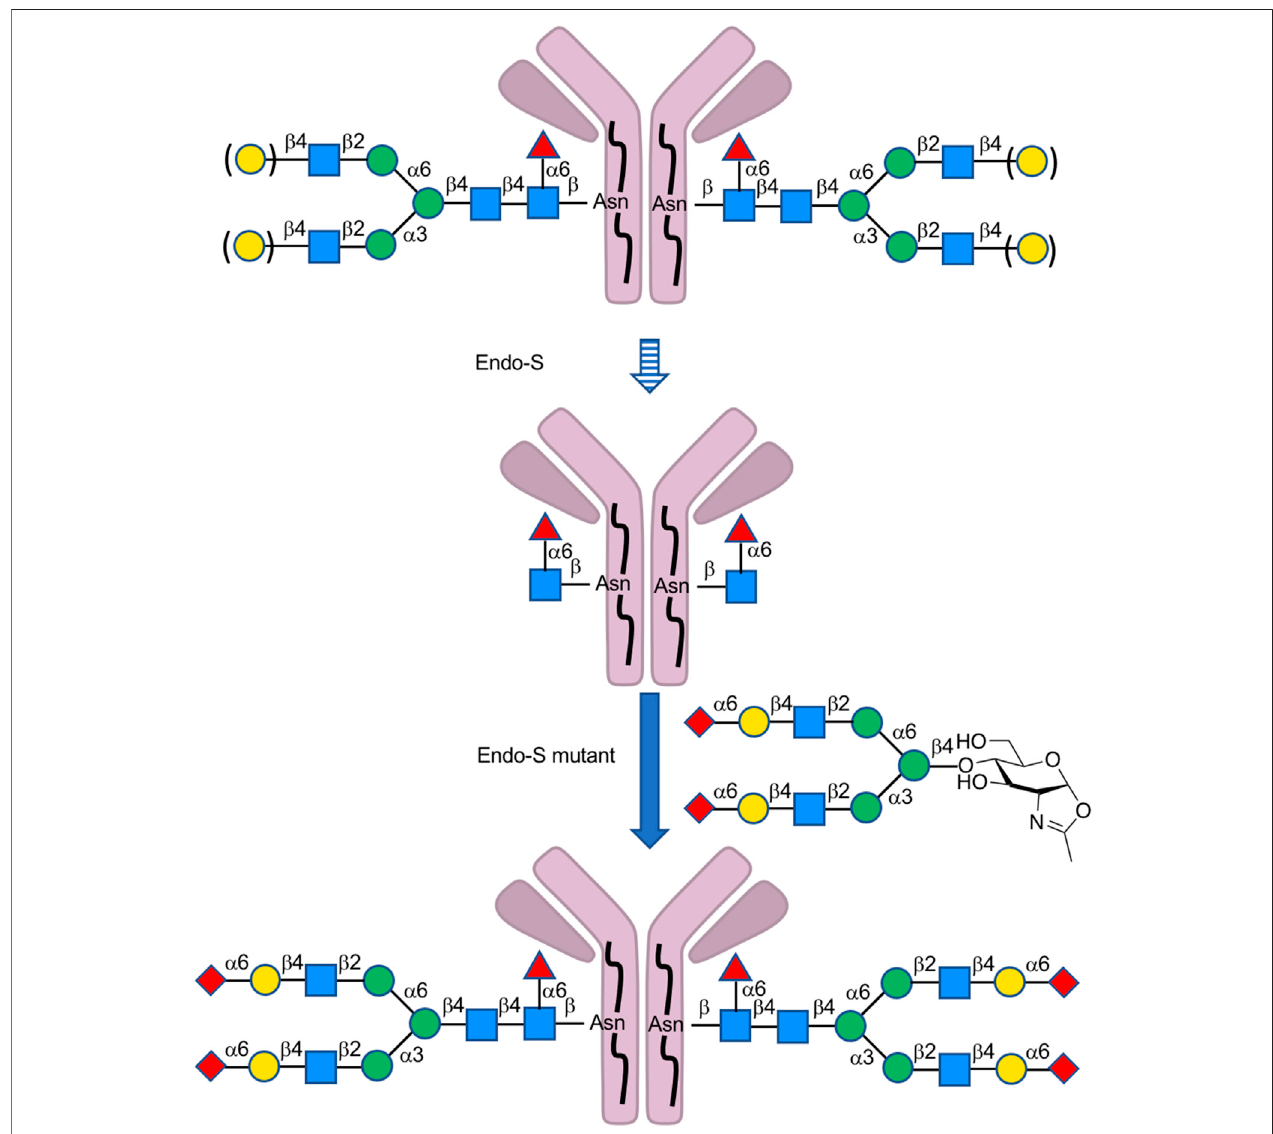
FIGURE 14 | Preparation of homogeneous N -glycan-linked antibody-mediated by Endo-type enzymes.